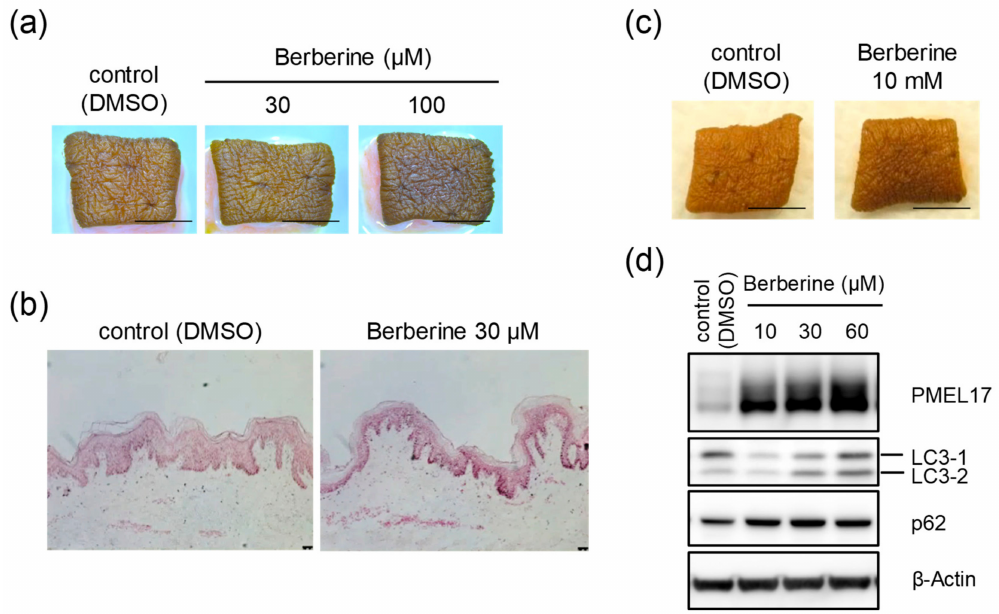
Figure 5. Berberine induces skin darkening through the inhibition of melanosome degradation in NHEKs. ( a ) Skin tissues obtained from an AA subject (34y) were subjected to tissue culture with or without berberine for 8 days (at the indicated concentrations). Photographs show representative samples. Scale bars = 5 mm. ( b ) Skins obtained from the AA subject above were treated with or without 30 µ M berberine and then subjected to Fontana-Masson staining. Scale bars = 50 µ m. ( c ) Skin tissues obtained from the AA subject above were also subjected to tissue culture by topical application with or without 10 mM berberine for 8 days. Photographs show representative samples. Scale bars = 5 mm. ( d ) NHEKs were cultured with isolated melanosomes for 24 h. They were subsequently washed, and then cultured with or without berberine for another 24 h (at the indicated concentrations). After the incubation, proteins were harvested for Western blot analysis of PMEL17, LC3 and p62 proteins. β -Actin = loading